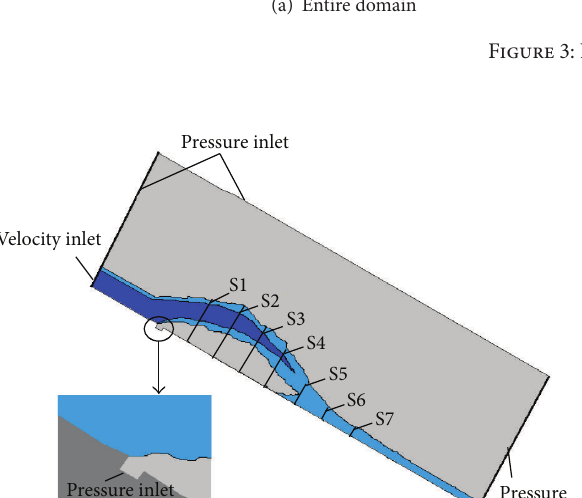
Figure 3: Numerical grid.